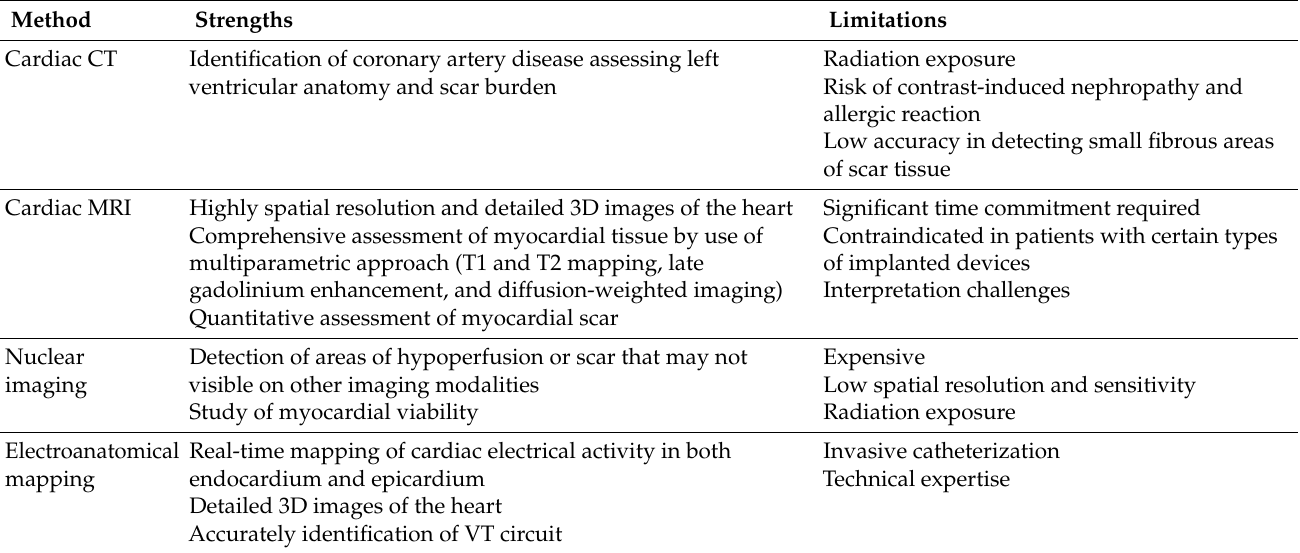
Table 2. Strengths and limitations of imaging modalities to identify structural aspects related to